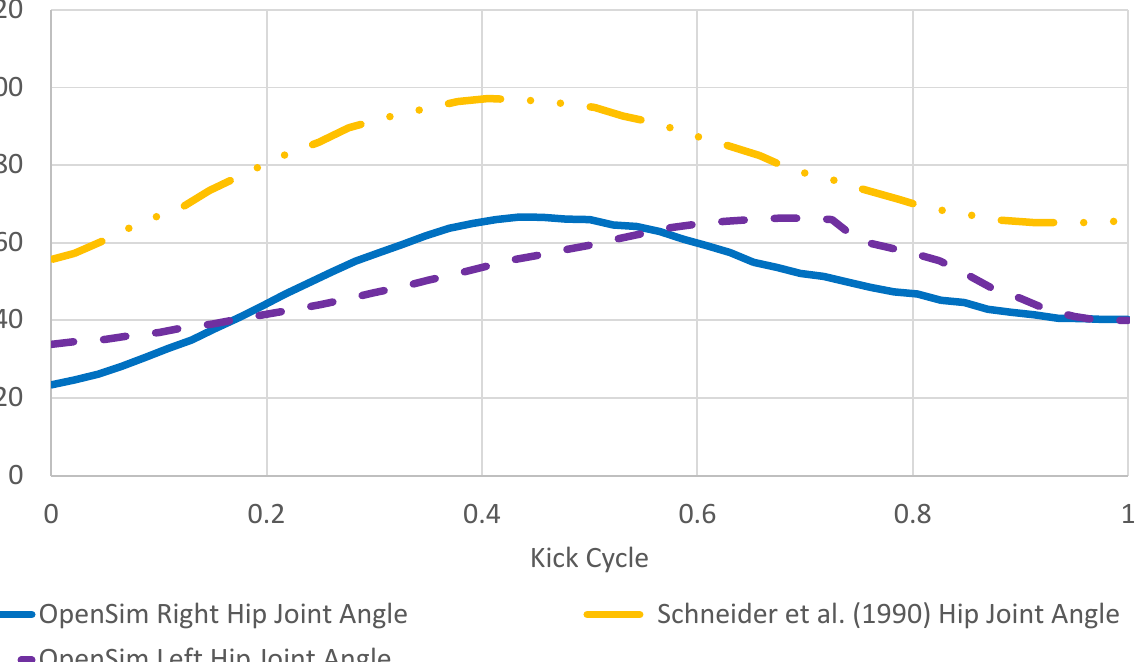
Figure 6. Time normalized hip joint ROM comparison between infant model and Schneider et al.’s [33]. Hip joint moment data obtained through the musculoskeletal model were also normal- ized and compared to values reported in the literature [33]. In both results, a decrease in moment was observed during hip flexion, and an increase in moment was observed during the extension of the hip, as shown in Figure